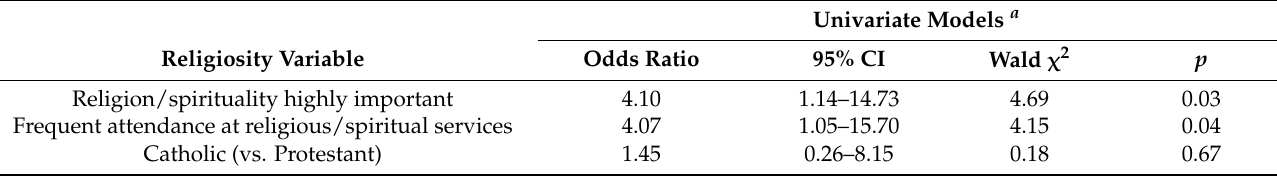
Table 2. Odds ratios of recurrence or onset of Major Depressive Disorder in 79 adult offspring of depressed and nondepressed parents between 20- and 25/30 year follow-ups associated with religiosity variables at year 20. Univariate Models a